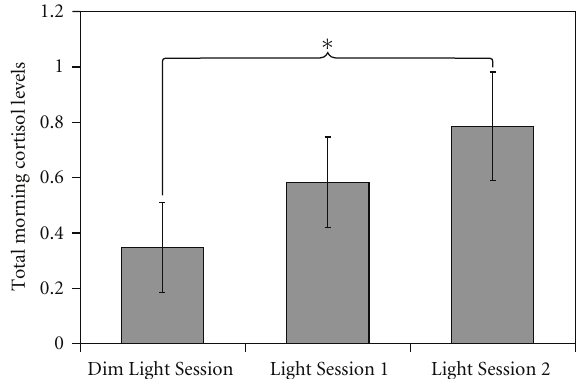
Figure 1: Total morning cortisol levels during the 80 minutes of data collection [(area under the curve (AUC)] were lower during dim light than during blue light exposure. Although the AUC was greater during blue light exposures than during the Dim Light Session, the di ff erence was statistically significant only for the second session. Shown are the mean ± SEM total cortisol levels (AUC for 80 minutes) for each experimental